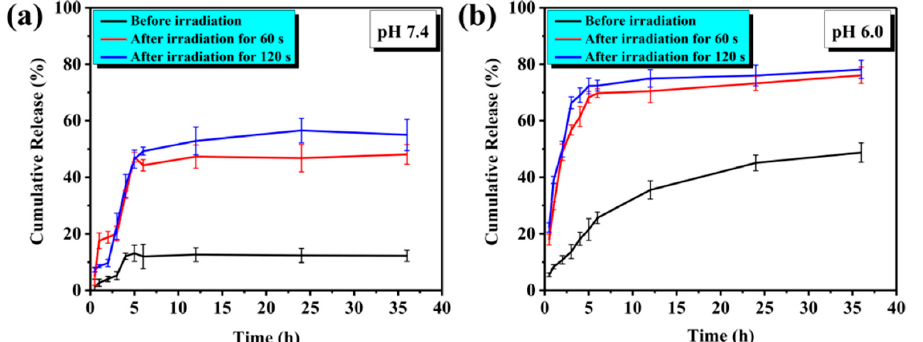
Figure 6. Effect of light on drug release from photosensitive TK-based DDS at different pH. Cumu- lative release profile at ( a ) pH 7.4 and ( b ) pH 6.0, comparing irradiated to non-irradiated DDS. Re- produced from the open source journal of International Journal of Molecular Sciences; published by MDPI; 2021 [69].